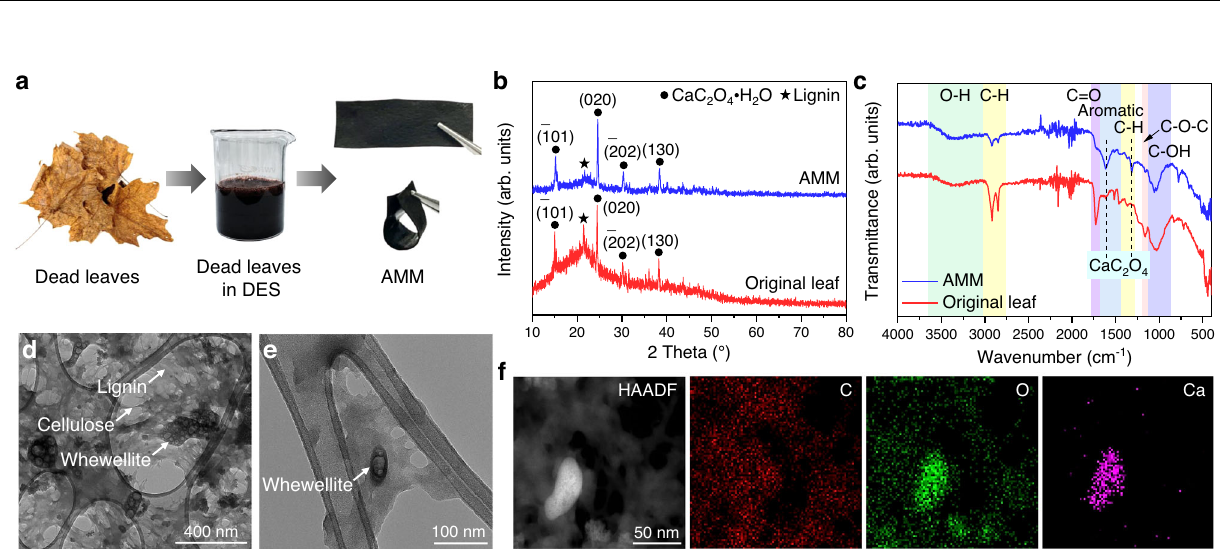
b XRD patterns of AMMand originalleaf. c FT-IR spectraofAMM and original leaf. d , e TEM images of AMM. f EDS elemental maps of